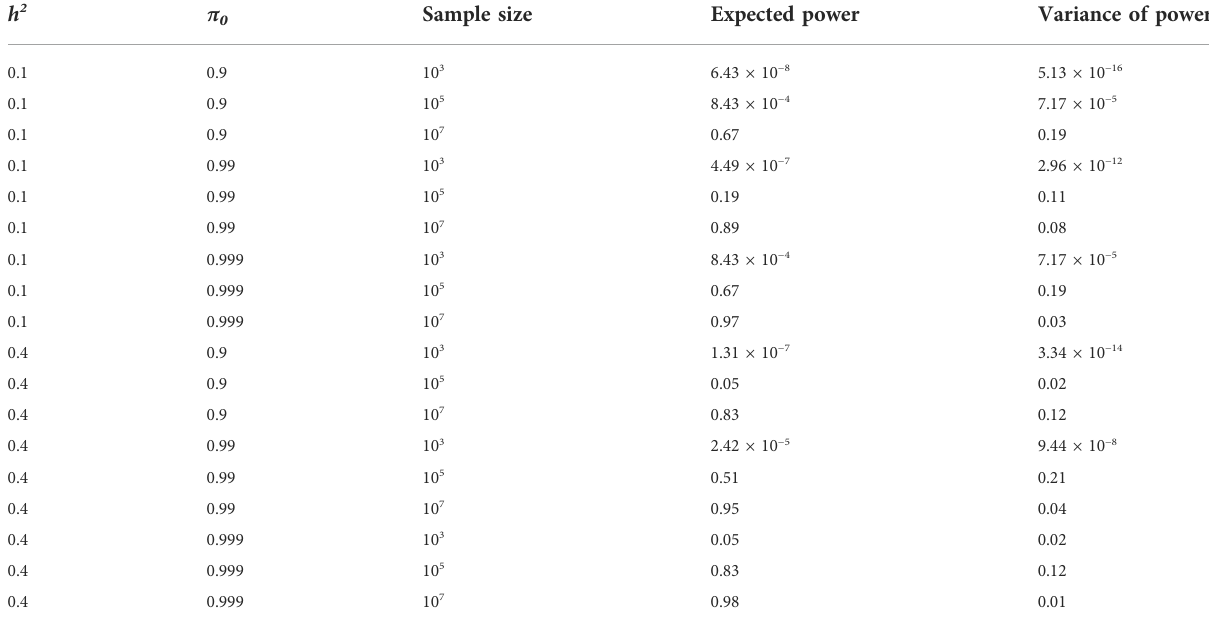
TABLE 2 The expectation and variance of statistical power across causal SNPs for different SNP heritability, polygenicity, and sample sizes. m = 60,000, α = 5 × 10 − 8 . h 2 π